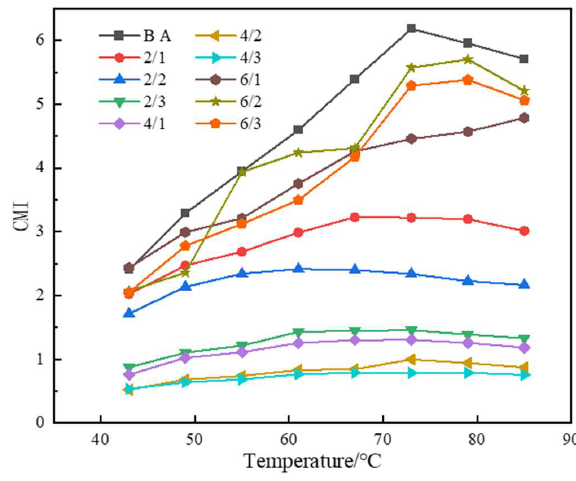
Figure 6. Temperature variation curves of different asphalt CMI.